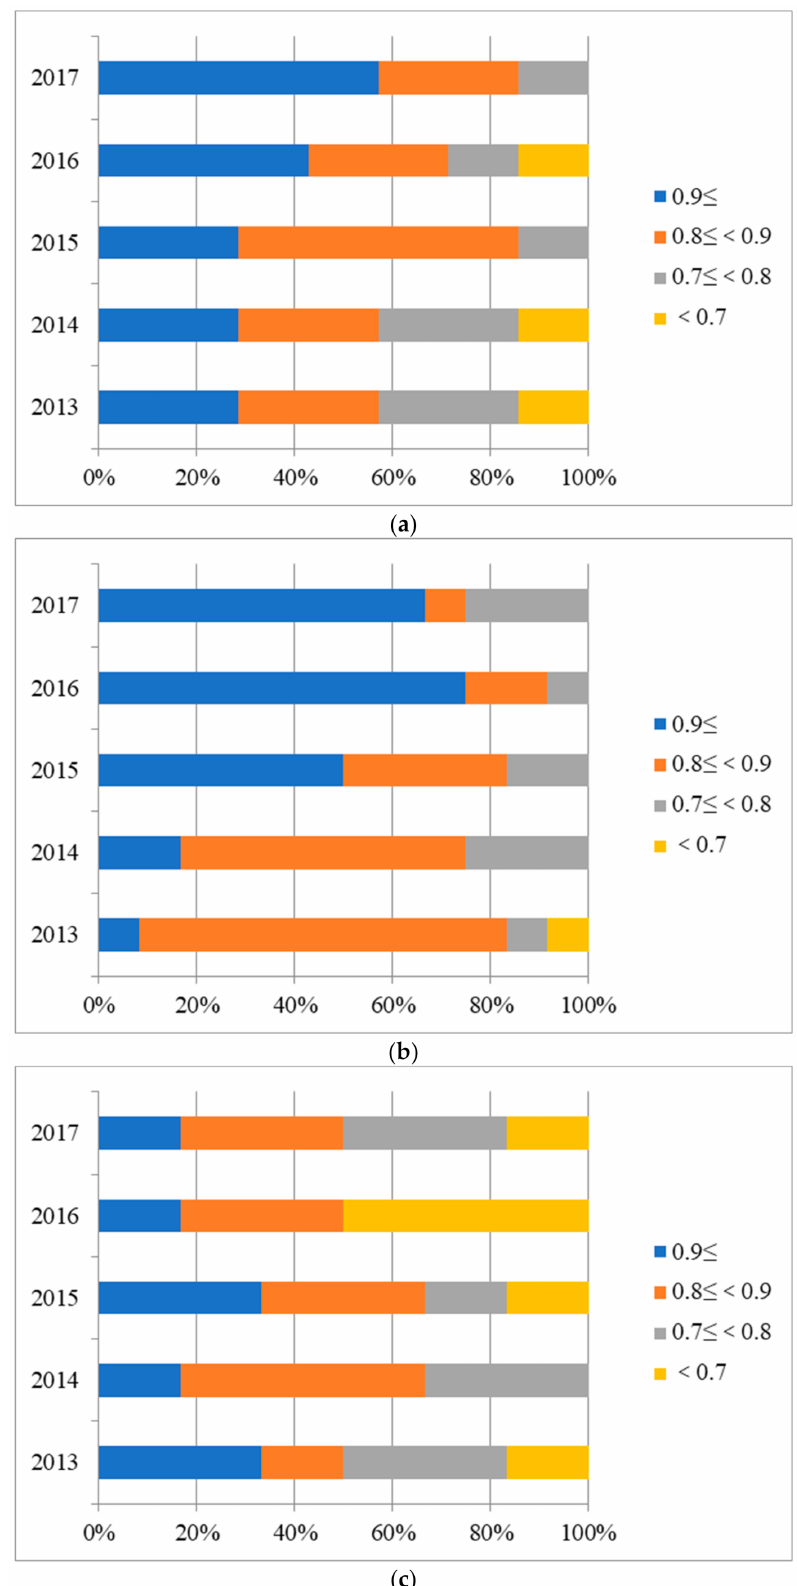
Figure 6. Distribution of the scores with bootstrapping of public hospitals based on Model